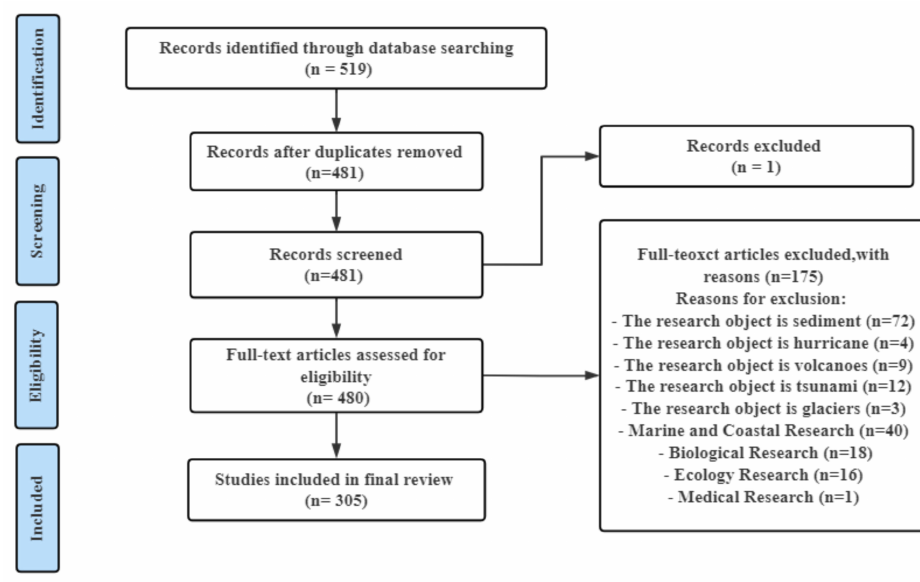
Figure 1. Search